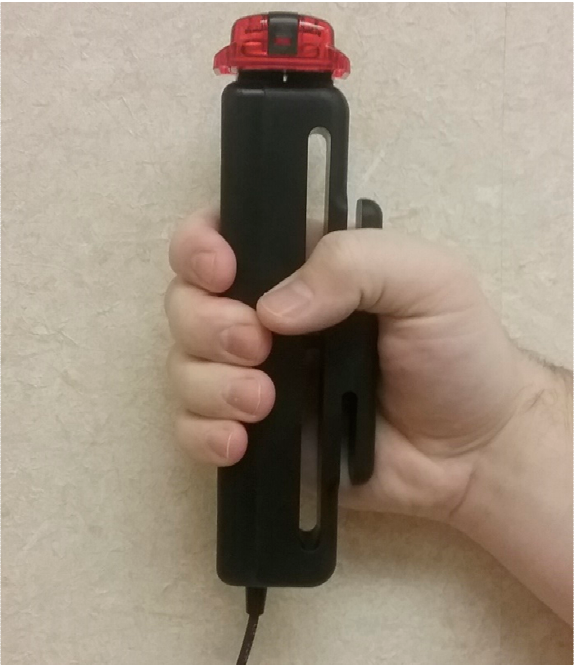
Figure 1. Image for how the dynamometer was securely attached to the accelerometer with velcro.